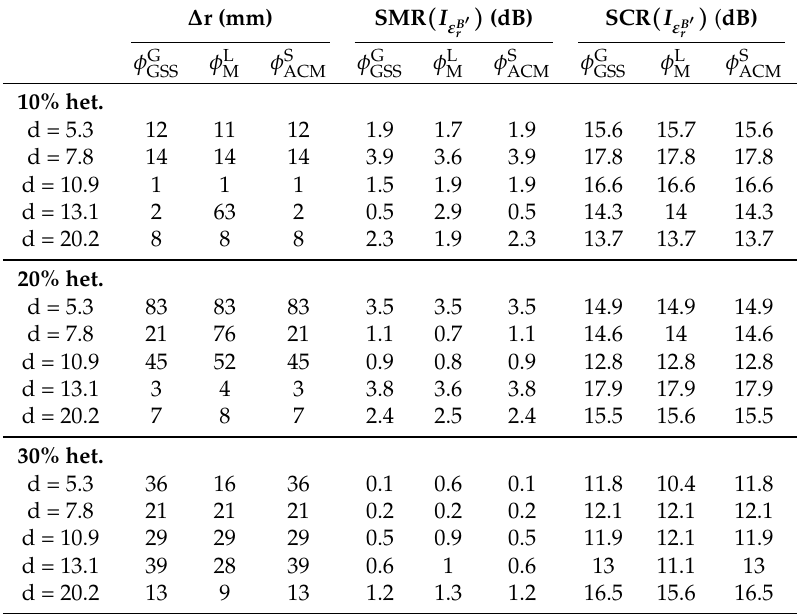
) and SCR ( I ) evaluated for spherical targets of increasing diameter in phantoms Table 3. ∆ r , SMR ( I ε B (cid:48) r ε B (cid:48) r of increasing